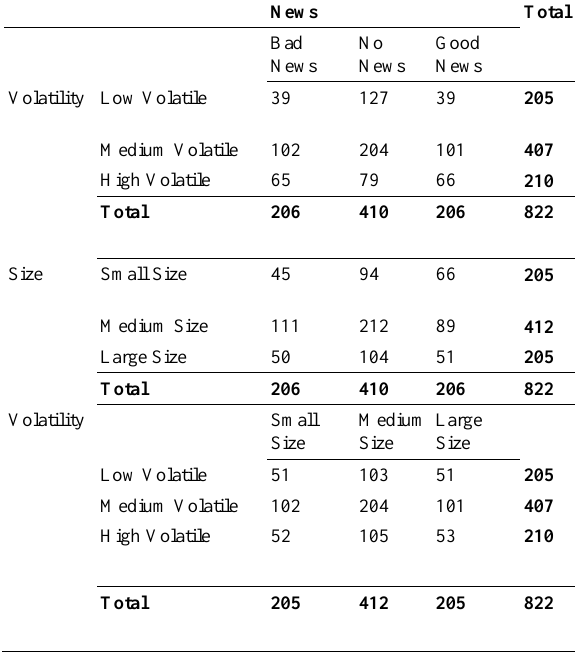
Table 1: Sampling of data